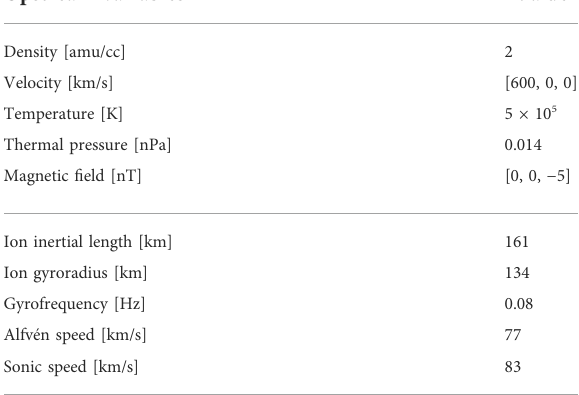
density run. Upstream variables